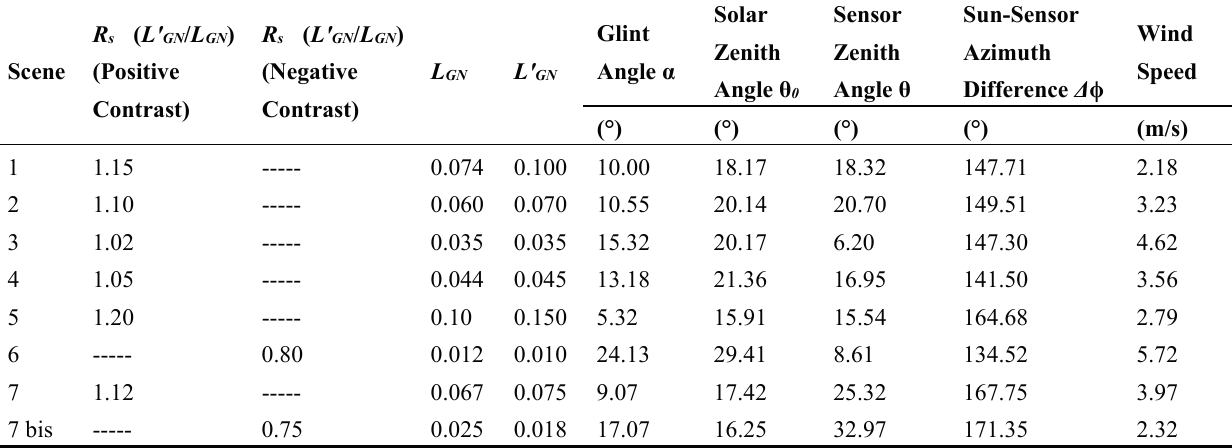
Table 3. Set of parameters used to characterize oil spills in glint-contaminated MODIS imagery. R s are the lower (positive contrast spills) and upper (negative contrast) limit R values for detection (curves in Figure 6). All other values are mean values computed over the oil spill ROIs, where R ≥ R s ( R ≤ R s ) for positive (negative) contrast cases (70% of ROI pixels). Note that we split the last oil spill case (No. 7) into two rows, that is for positive and negative